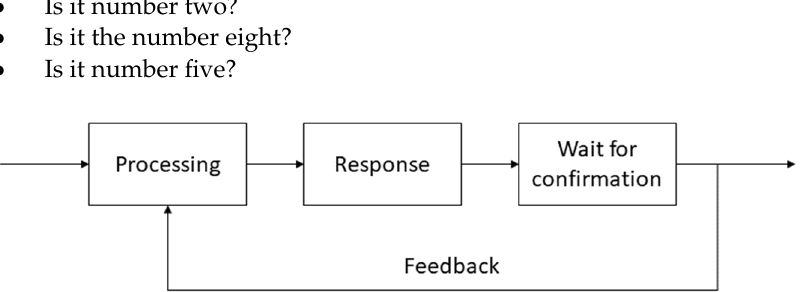
Figure A6. Scheme for the presentation of results and confirmation of successes or failures.